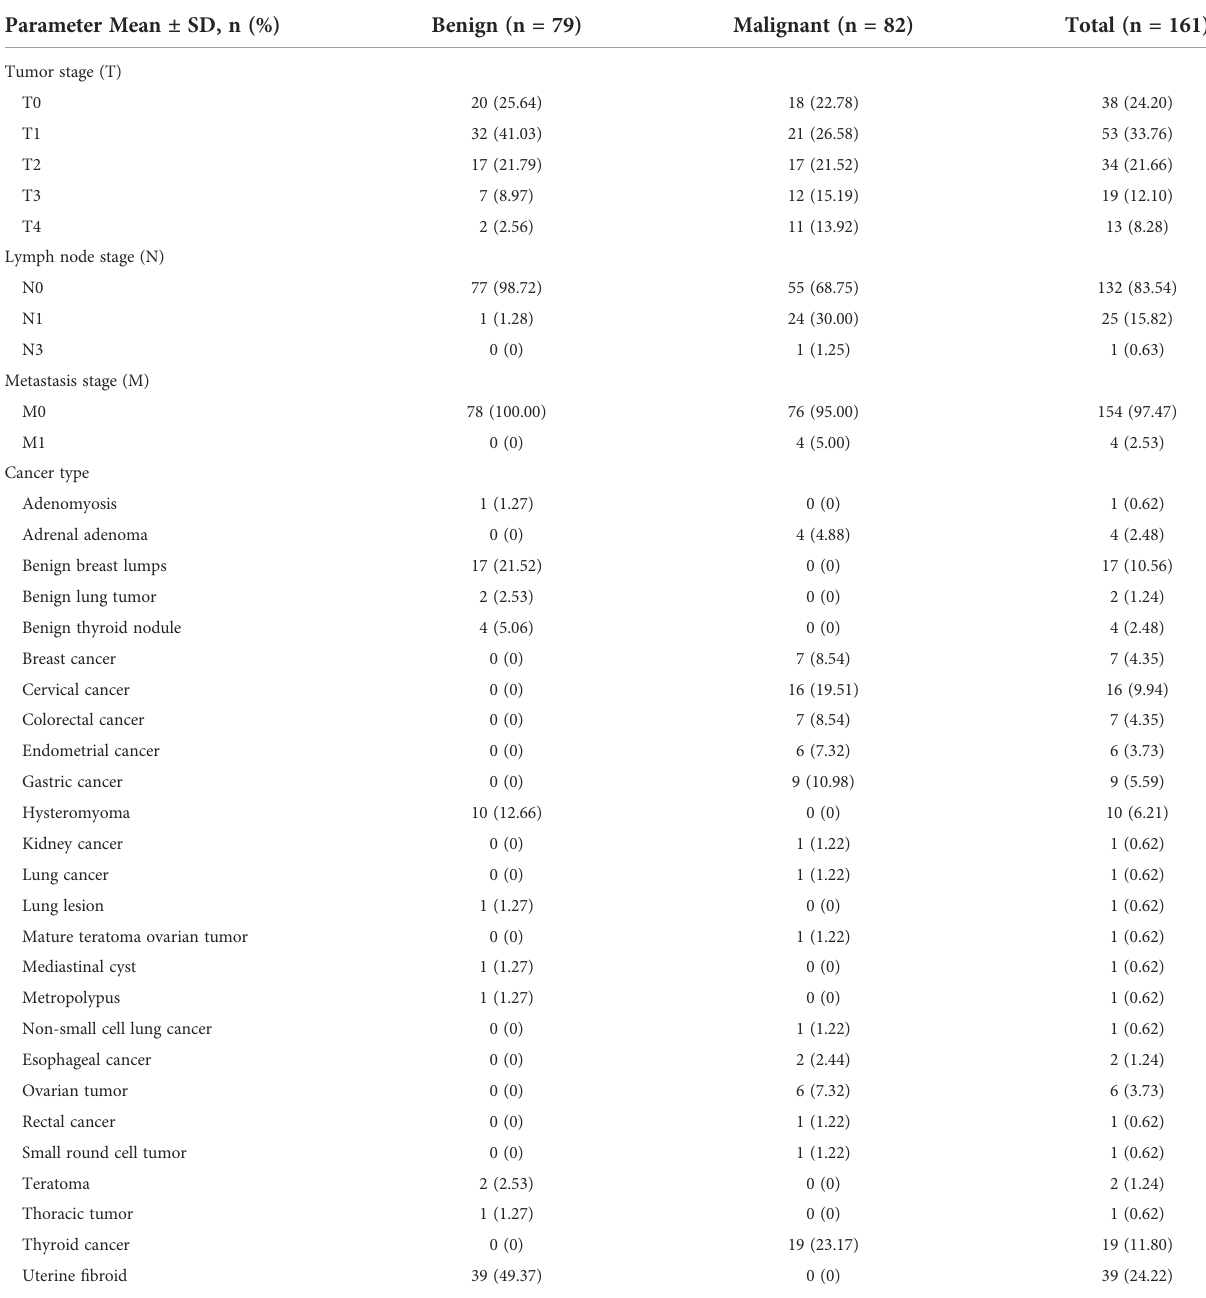
TABLE 2 Patients ’ tumor-related